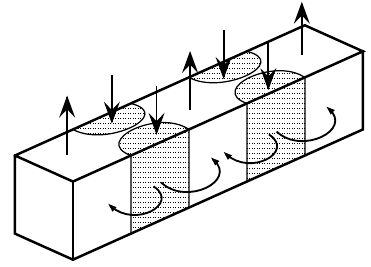
Figure 10. Expanding channel